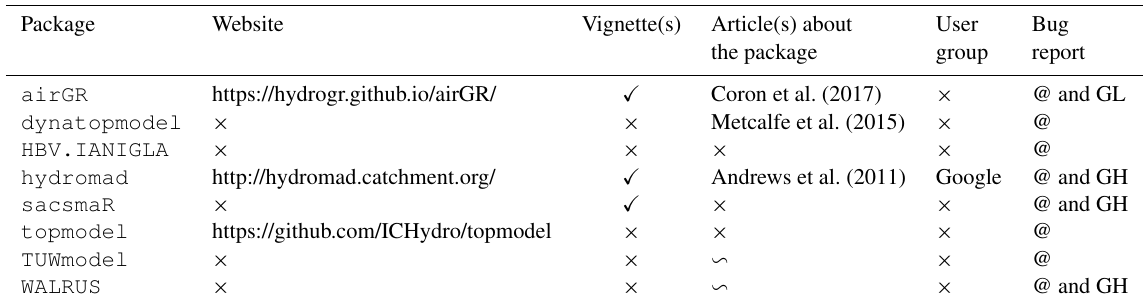
Table 8. Additional available package documentation and support. Note: @ – email; GL – GitLab; GH – GitHub (URLs in this table were last accessed on 20 September